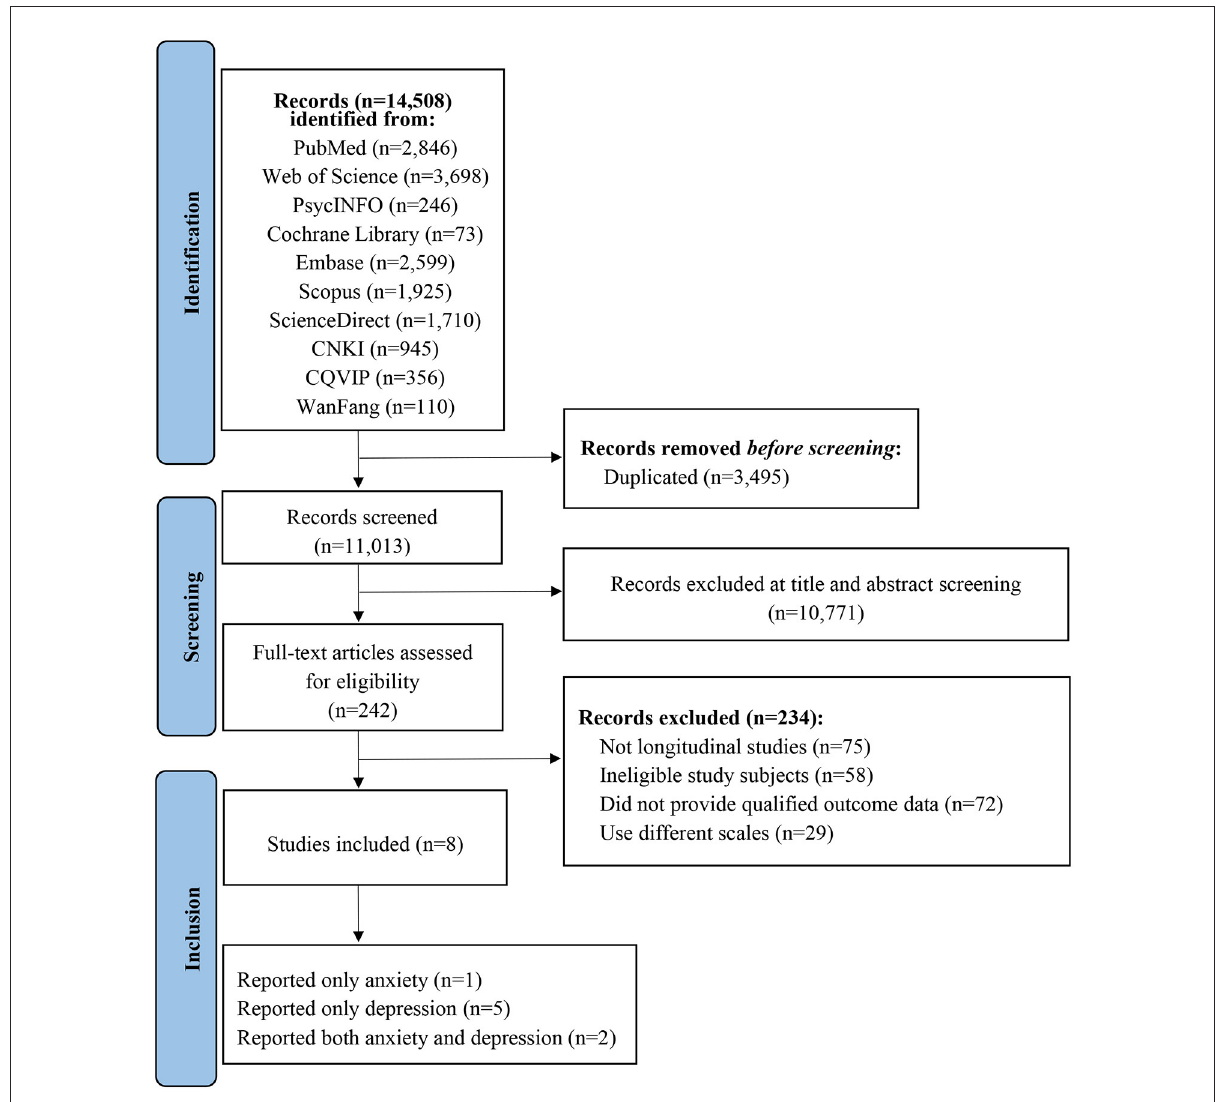
FIGURE1 Flowchart of literature search and study selection according to the PRISMA